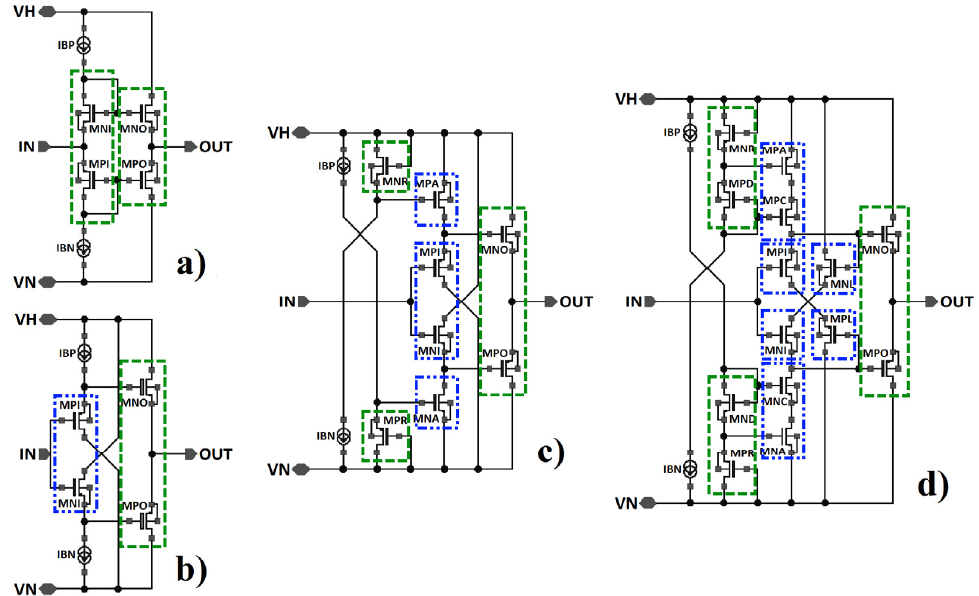
Figure 1. Symmetrical buffers: ( a ) gate follower; ( b ) source follower; ( c ) modified basic modified buffer; ( d ) augmented buffer [1].